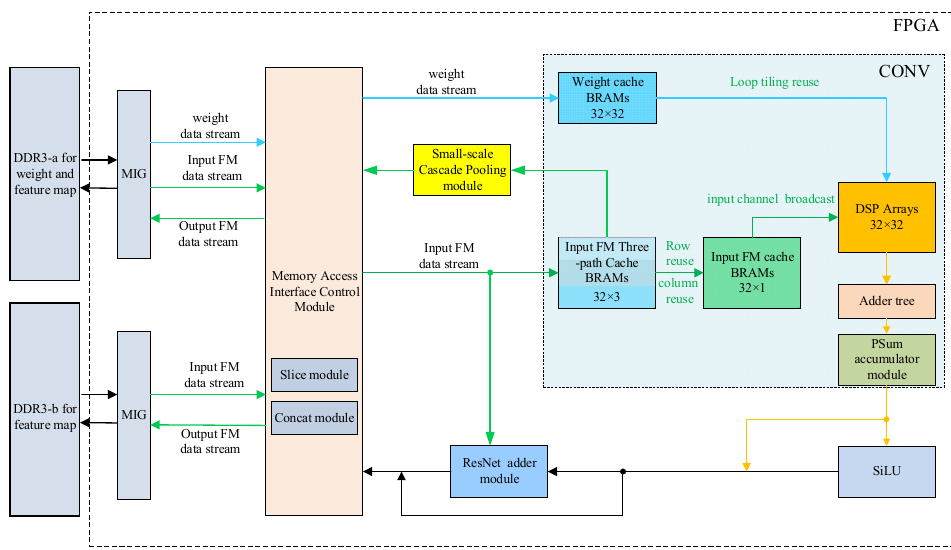
Figure 2. The overall architecture of the